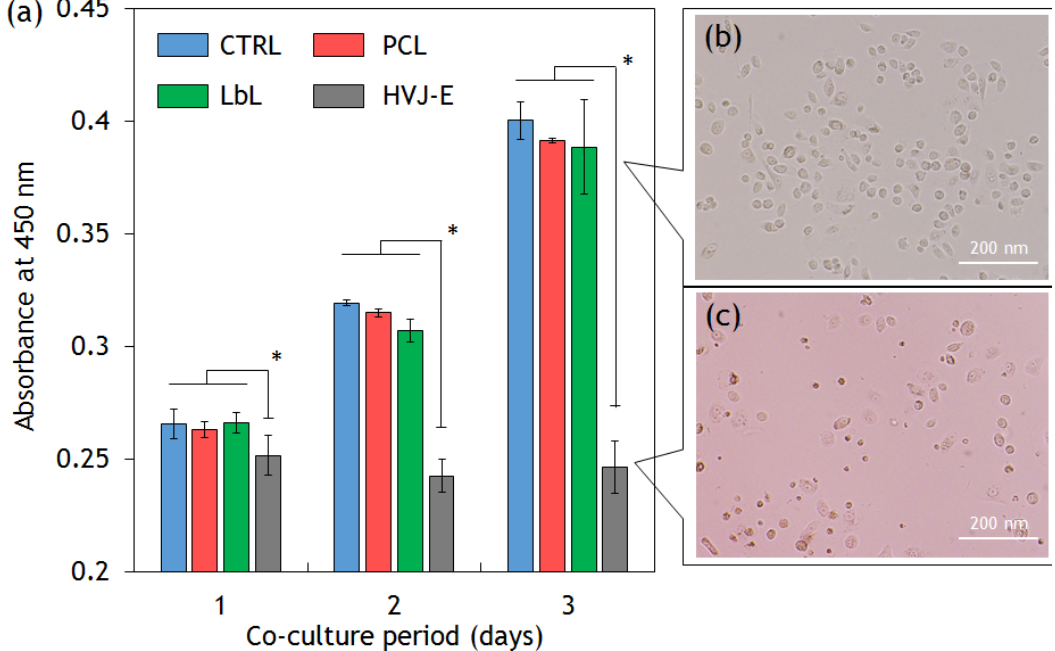
Figure 6. ( a ) Cytotoxic assays. The viability of PC ‐ 3 cells was tested using cell counting kit ‐ 8 assay. The cells were co ‐ cultured with PCL, LbL coated (PLL outermost), HVJ ‐ E immobilized (HVJ ‐ E) nanofiber mesh (student’s t test p < 0.01). The phase contrast images of PC ‐ 3 cells ( b ) without HVJ ‐ E immobilized nanofiber mesh; and ( c ) with HVJ ‐ E immobilized nanofiber mesh. nanofiber mesh; and ( c ) with HVJ-E immobilized nanofiber